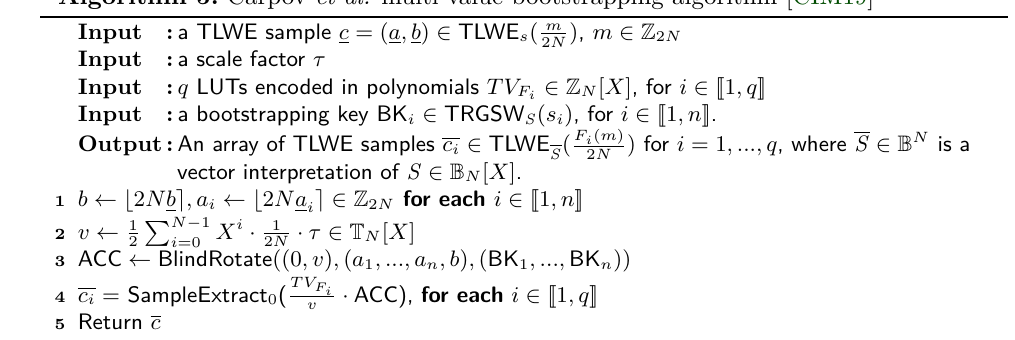
Algorithm 5: Carpov et al. multi-value bootstrapping algorithm